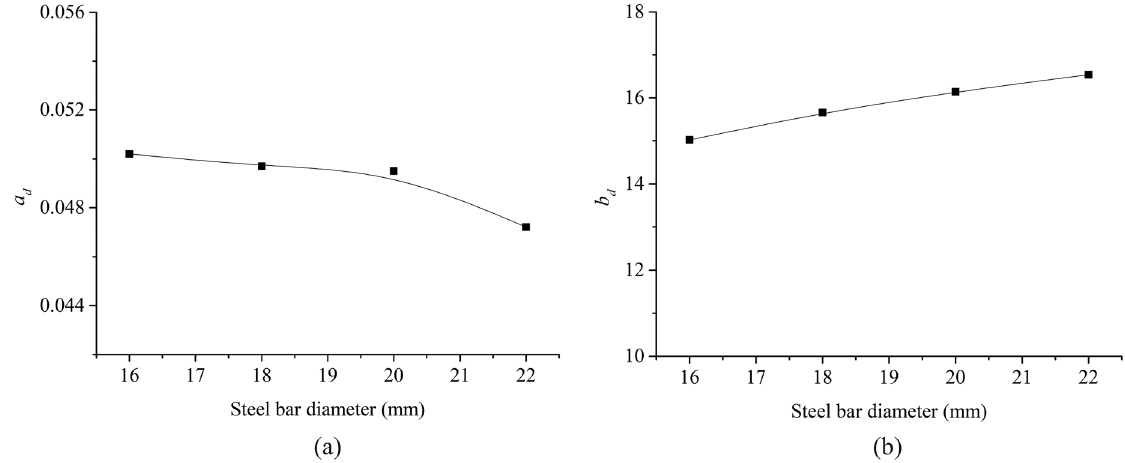
Figure 4: Parameters a d and b d of specimens with di ff erent steel bar diameters. ( a ) Parameter a d ; ( b ) Parameter b